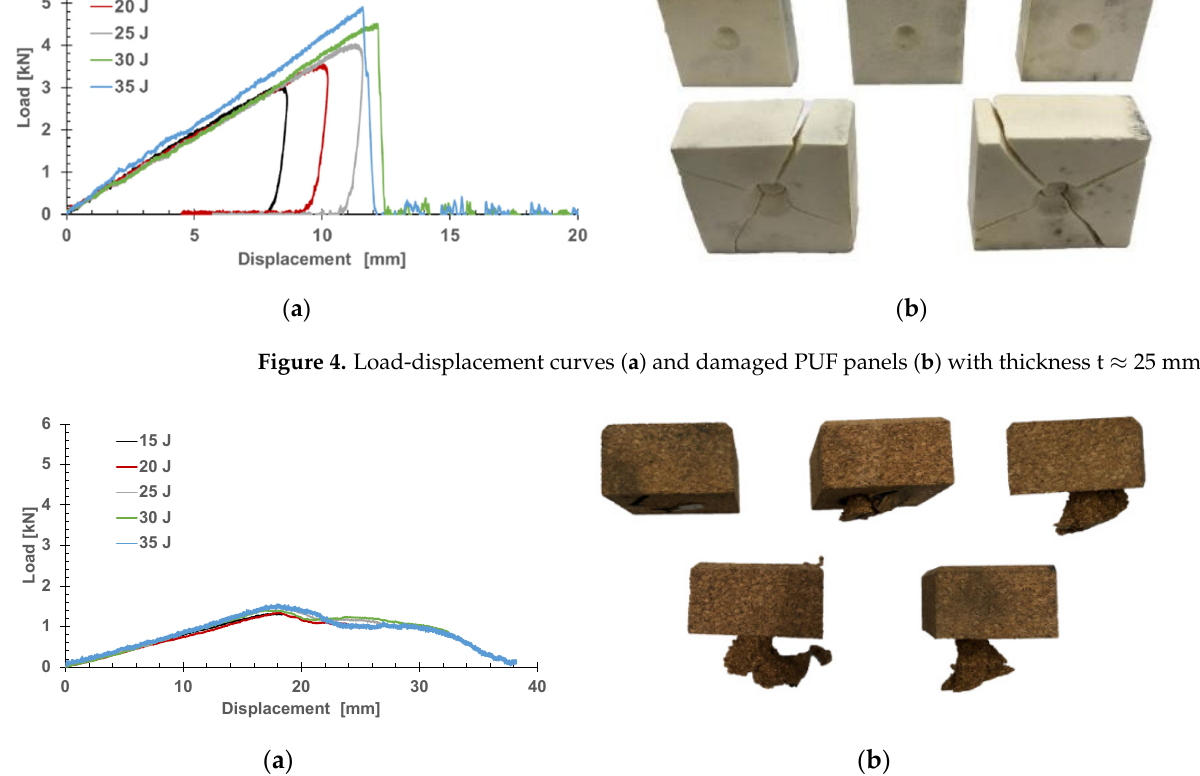
Figure 5. Load-displacement curves ( a ) and damaged AC ( b ) panels with thickness t ≈ 35 mm.